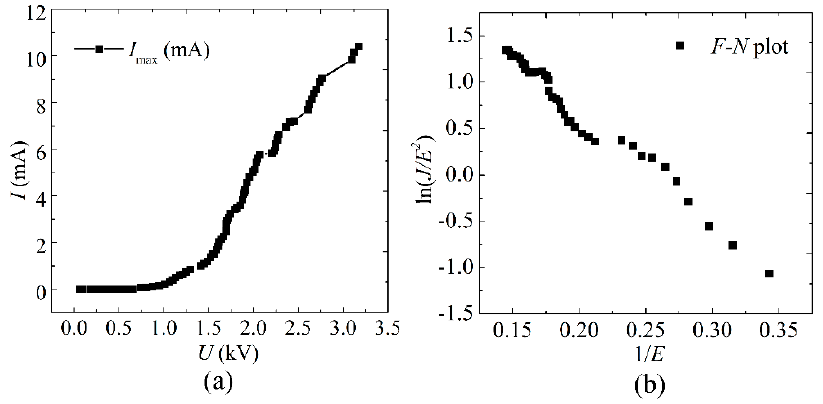
Figure 7. ( a ) The maximum emission current of the screen-printed SWCNT cathodes at pulse mode. ( b ) The corresponding F-N plot.